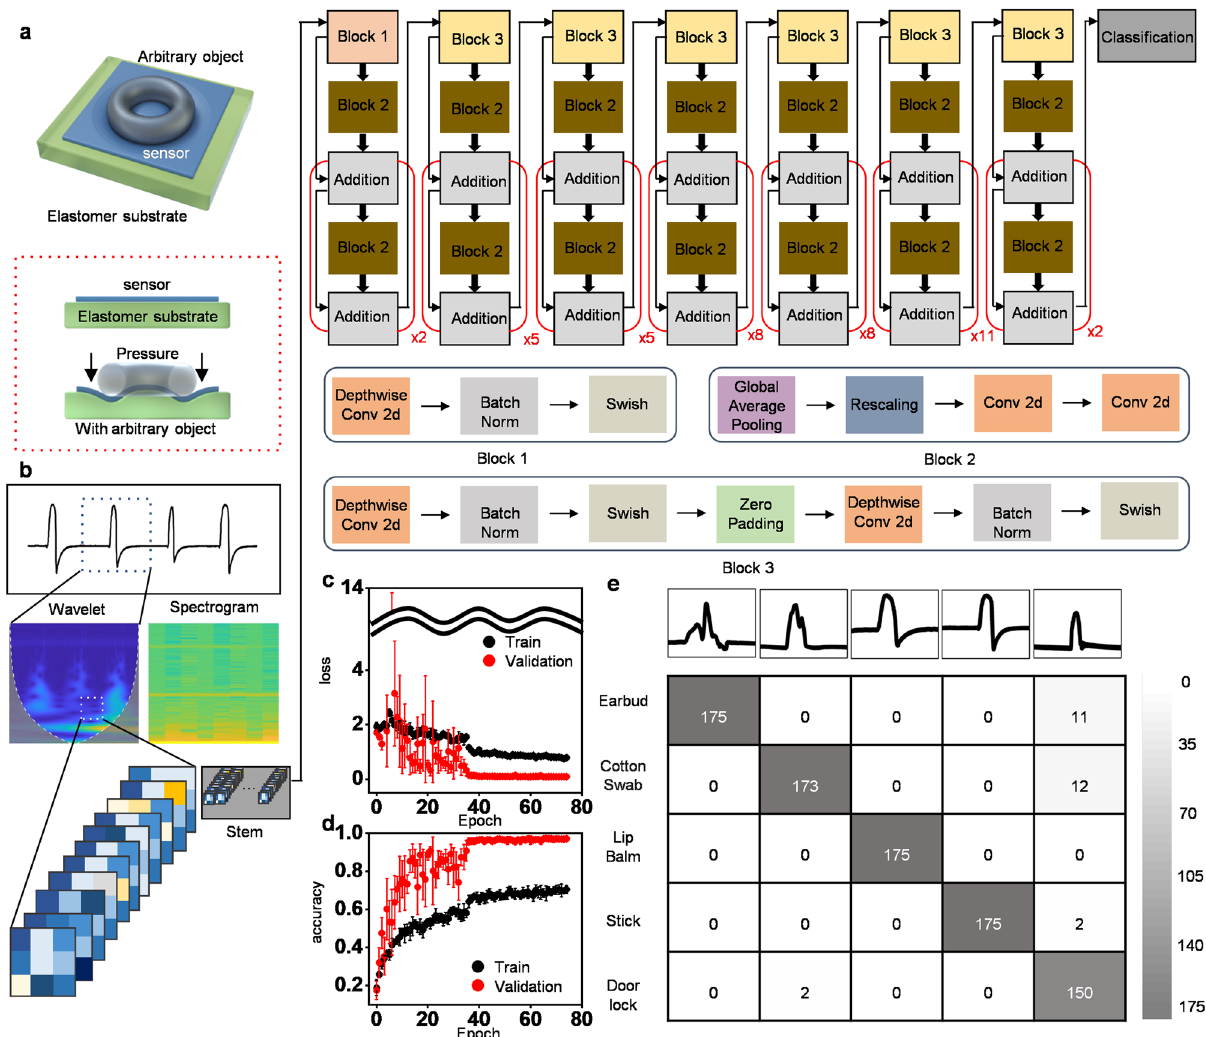
Fig. 4 Deep learning-aided data classi fi cation. a Illustration of the mechanical deformation and a corresponding change of the sensor. Pressure applied to the stimulus point leads to the nonlinear behavior in the sensor signal. b The overall data processing sequence summarized with three steps. (1) Cropping the 1D time-series data. (2) Conversion of the cropped signal into the 2D image by the signal processing method of wavelet transform. (3) Transfer-learning a pre-trained CNN with the processed 2D image. c Epoch-loss graph of the fi ve- fold cross validation results with the mean and standard deviation for each epoch in the classi fi cation of the mechanically stimulating object. d Epoch-accuracy graph of the fi ve-fold cross validation results with the mean and standard deviation for each epoch of the classi fi cation. e Confusion matrix depicting the comprehensive classi fi cation results of the test set by each cross validation trained model with the representative raw